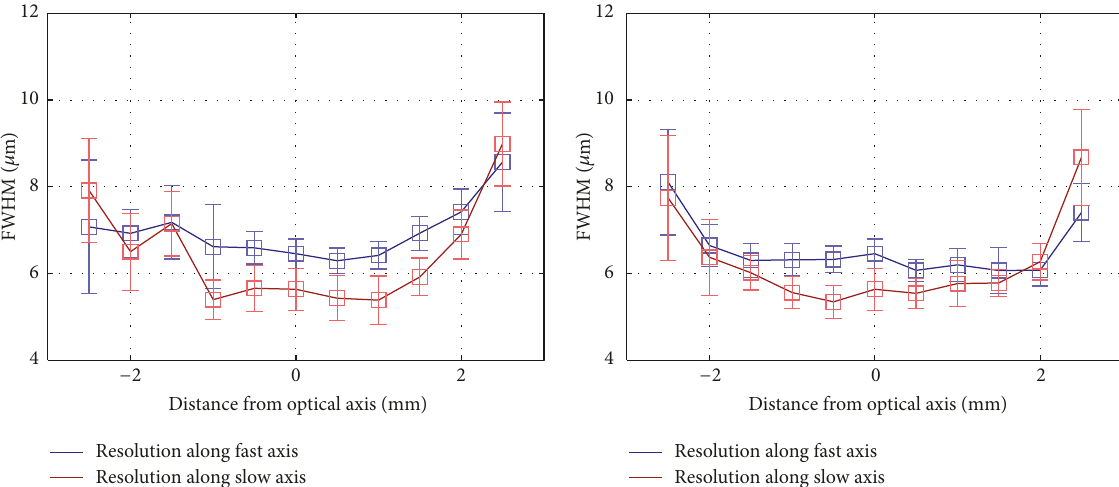
Figure 7: Variation in the lateral resolution of the implemented SD-OCT. Within the radius of 2 mm, the FWHM resolution stays below 7.1 𝜇 m. The maximum diffraction limited field of view for this objective is ∼ 4.7mm in diameter. When approaching this limit, the FWHM increases to ∼ 8 𝜇 m. The error bars mark the standard deviations. There are at least 70 measurements at each location.